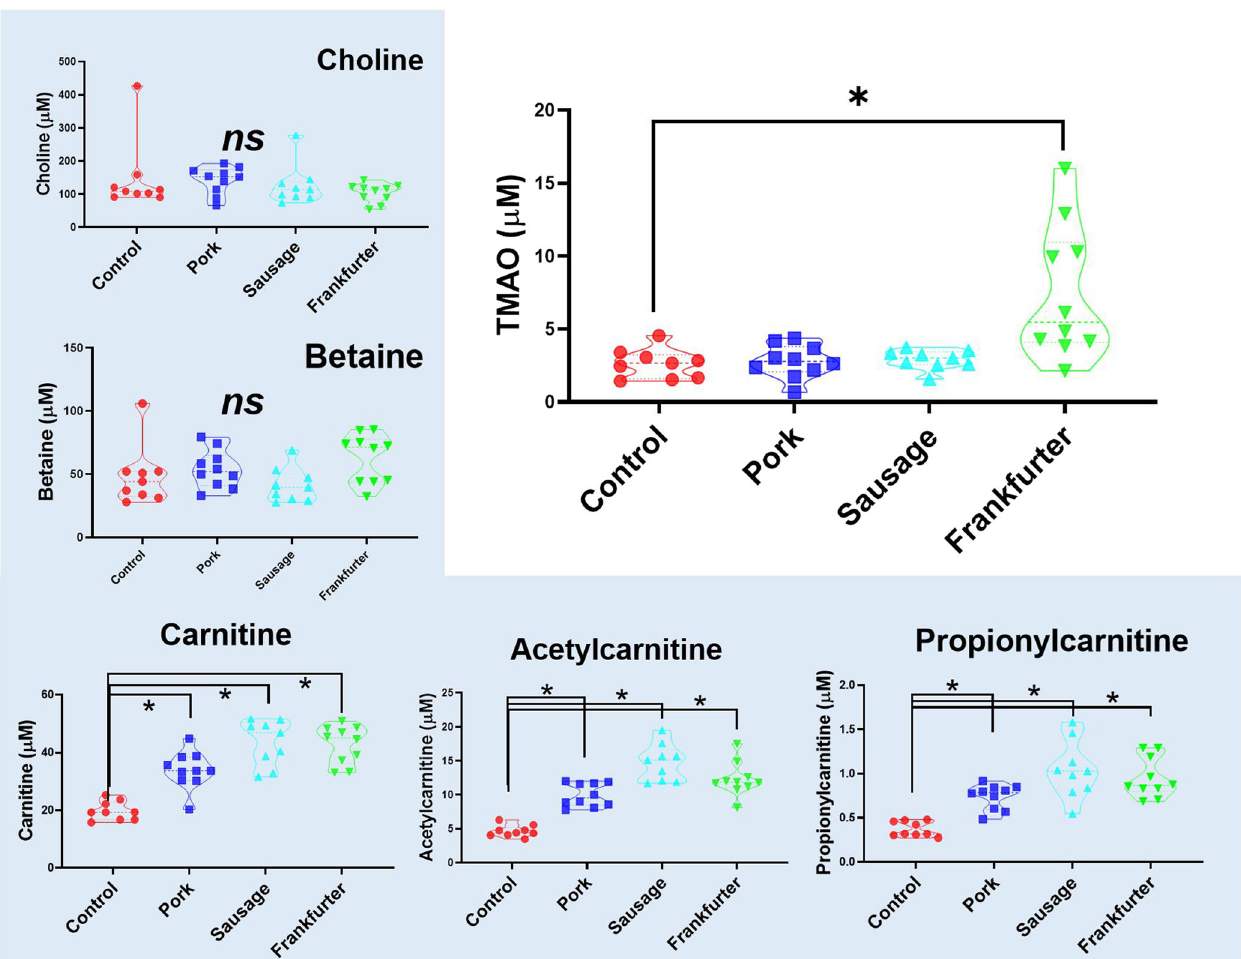
Fig. 3 Serum TMAO (trimethylamine N-oxide) is higher and more variable in mice receiving frankfurter diet, yet TMAO precursor metabolites are not similarly affected. Serum levels of TMAO (at 56 days), typically formed from choline, betaine, and carnitines were signi fi cantly higher in mice receiving frankfurter-containing chow. Levels of choline and betaine did not differ between groups. Mice consuming any meat-containing chow had higher levels of carnitine, acetylcarnitine, and propionylcarnitine. Control samples are shown in red ( n = 9), minced pork in dark blue ( n = 10), nitrite-free sausage in light blue ( n = 9), and frankfurter (nitrite-containing) in green ( n = 10). Data shown are violin plots containing individual samples values with the median and quartile values represented as dotted